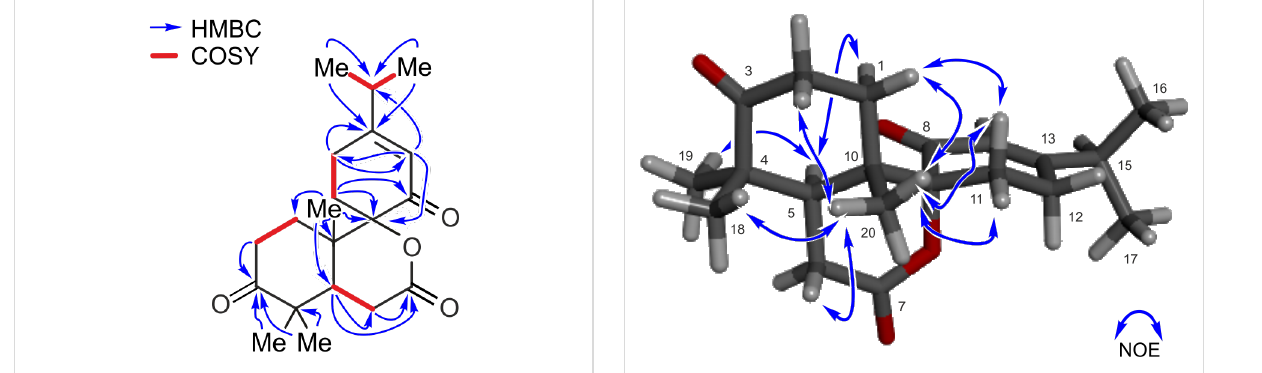
those from H-14 to C-9 and C-12 indicated the presence of a ∆ 13,14 double bond. HMBC correlations from H 3 -18, H 3 -19, and H 2 -2 to the carbon at δ C 213.1 suggested the location of a keto group at C-3, whereas those from H 2 -11 to the carbon at δ C 195.9 indicated that there was another keto group at C-8 (Figure 2).